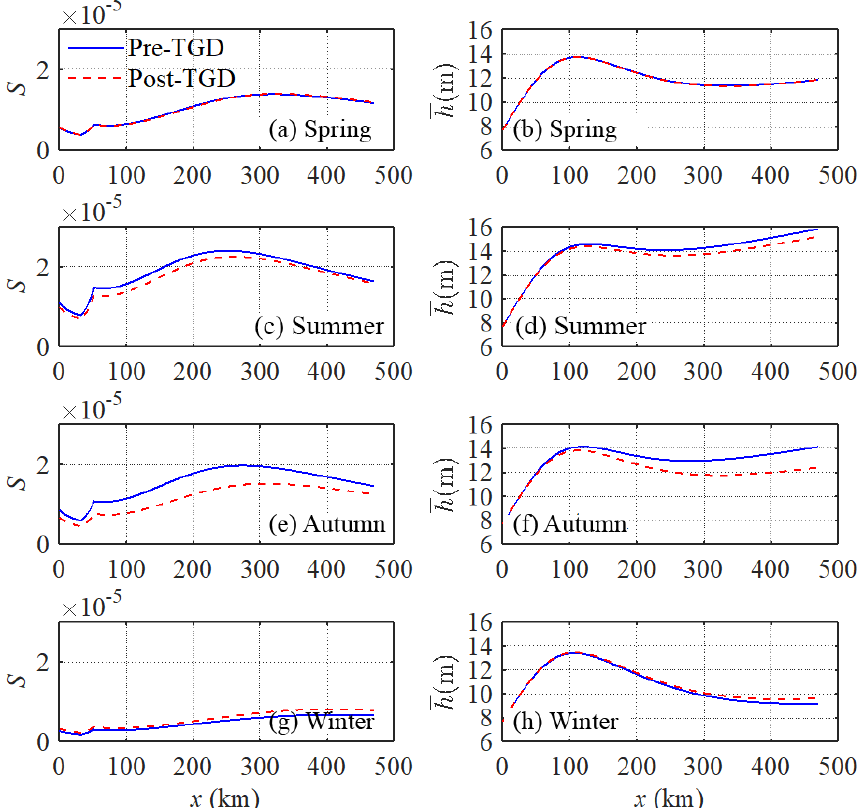
Figure 9. Longitudinal variability of simulated residual water level slope S (a, c, e, g) and water depth h (b, d, g, i) along the Yangtze estuary in different seasons (spring: a, b ; summer: c, d ; autumn: e, g ; winter: g, i ) for both the pre-TGD and post-TGD